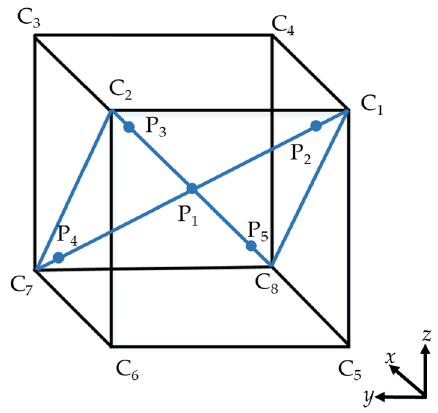
Table 6. The nominal kinematic parameters of the ER20-C10 robot after calibration.